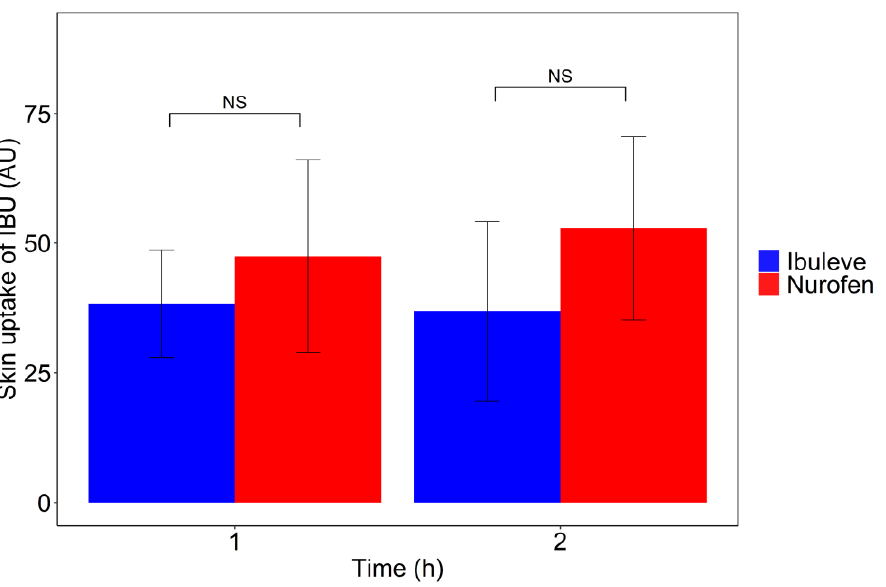
Figure 5. Area under the depth profile curve (AUC) values of IBU in the SC following a 1 h and 2 h application of formulations in vivo (mean ± SEM of 4 subjects; n = 8 replicates per subject).